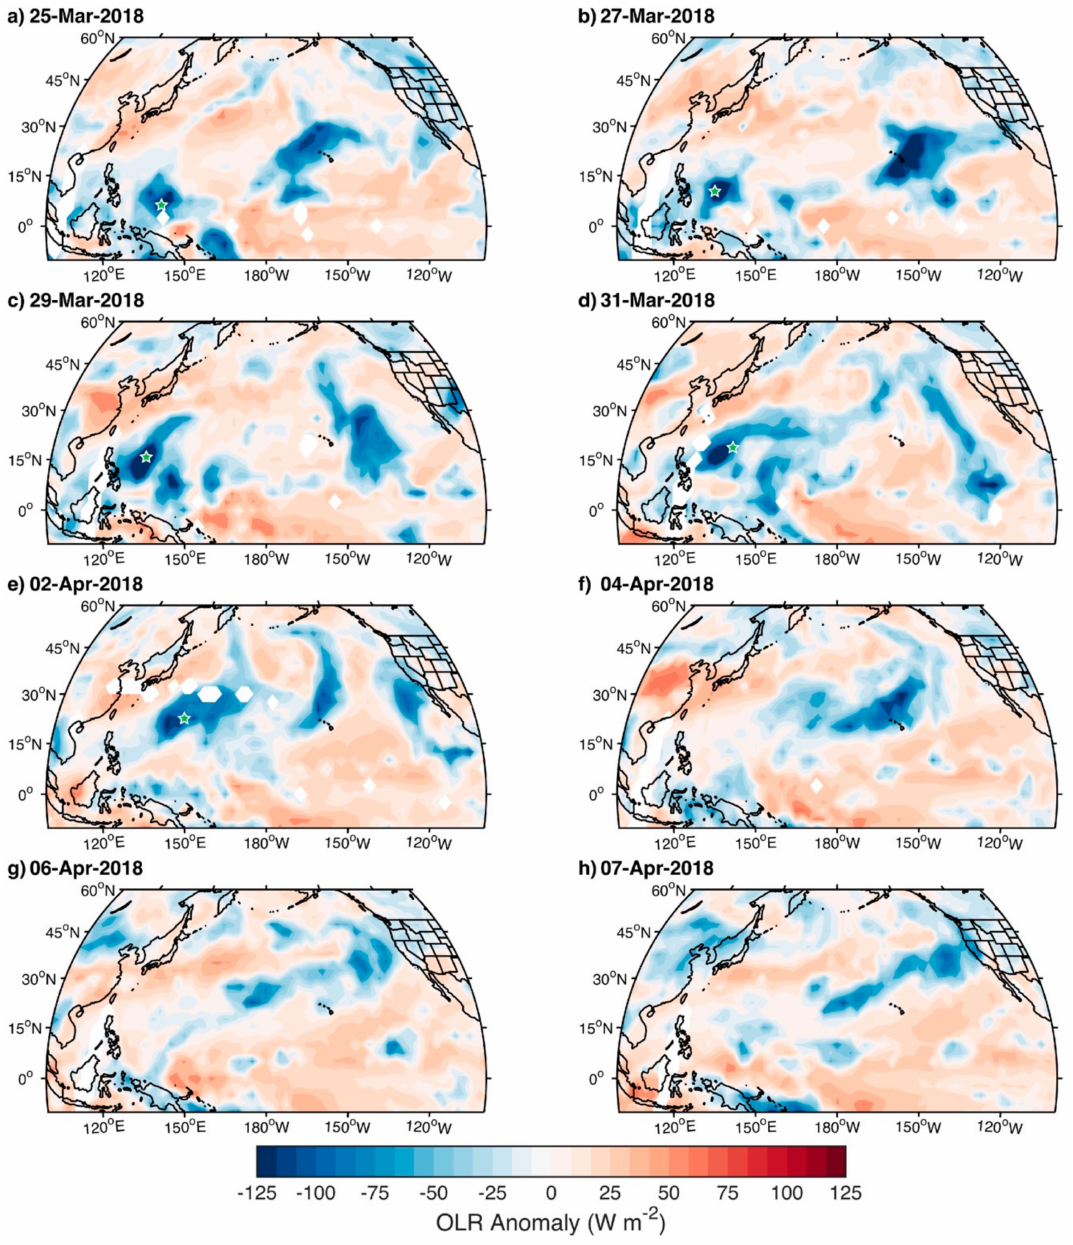
Figure 2. Non-interpolated outgoing longwave radiation anomalies (W m 2 ) for ( a ) 25 March 2018; ( b ) 27 March 2018; ( c ) 29 March 2018; ( d ) 31 March 2018; ( e ) 2 April 2018; ( f ) 4 April 2018; ( g ) 6 April 2018; ( h ) 7 April 2018. The green star denotes the approximate center of the typhoon based on Japanese Meteorological Agency Regional Specialized Meteorological Center (RSMC) Tokyo-Typhoon Center best track data [17] for panels ( a – d ). The typhoon center is estimated for panel ( e ) based on analysis of MERRA 1000 hPa geopotential height and sea level pressure